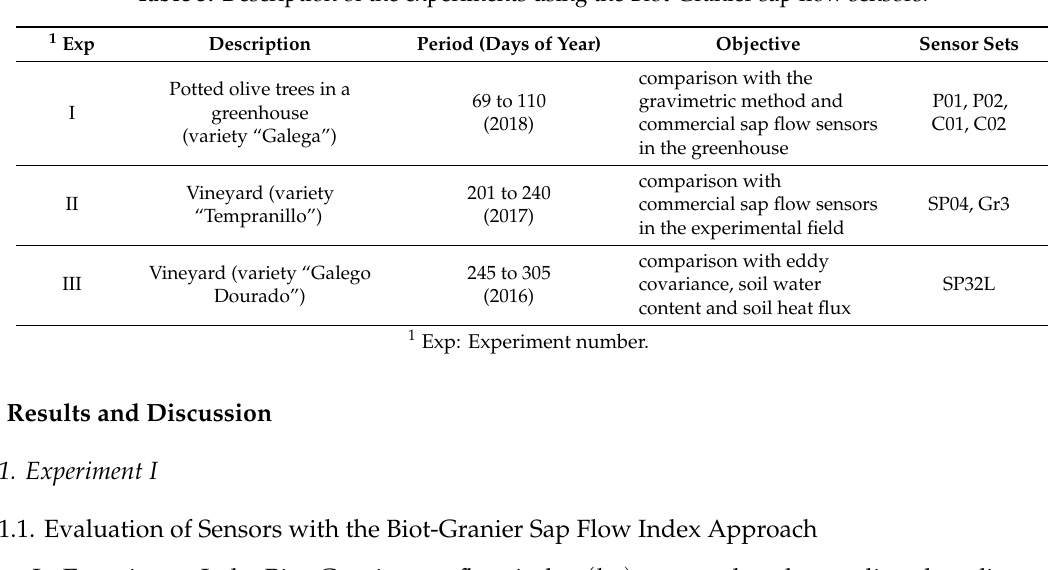
Table 3. Description of the experiments using the Biot-Granier sap flow